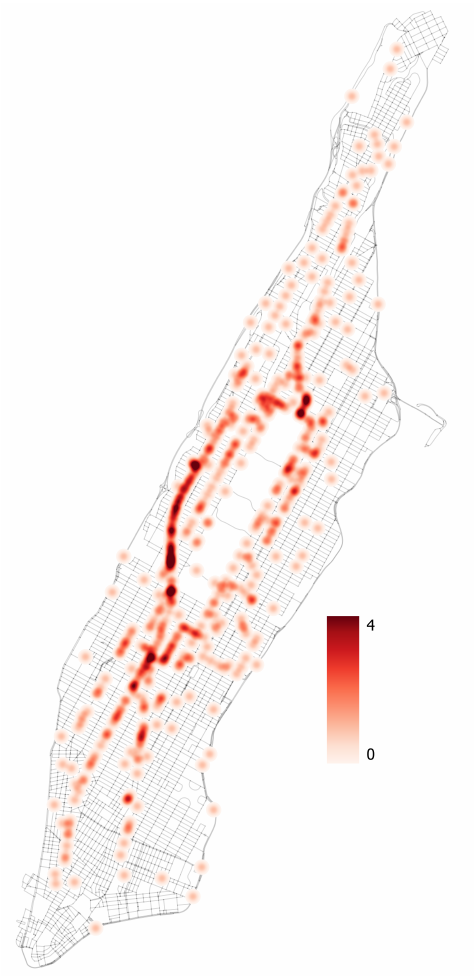
Figure 9. Traffic density heatmap of Manhattan urban network. The colour ramp depicts the traffic density from 1 to 4 drones per street within a search bandwidth of 100 m. The dark red region represents a high volume of traffic, whereas the faded coloured regions indicate low volume of